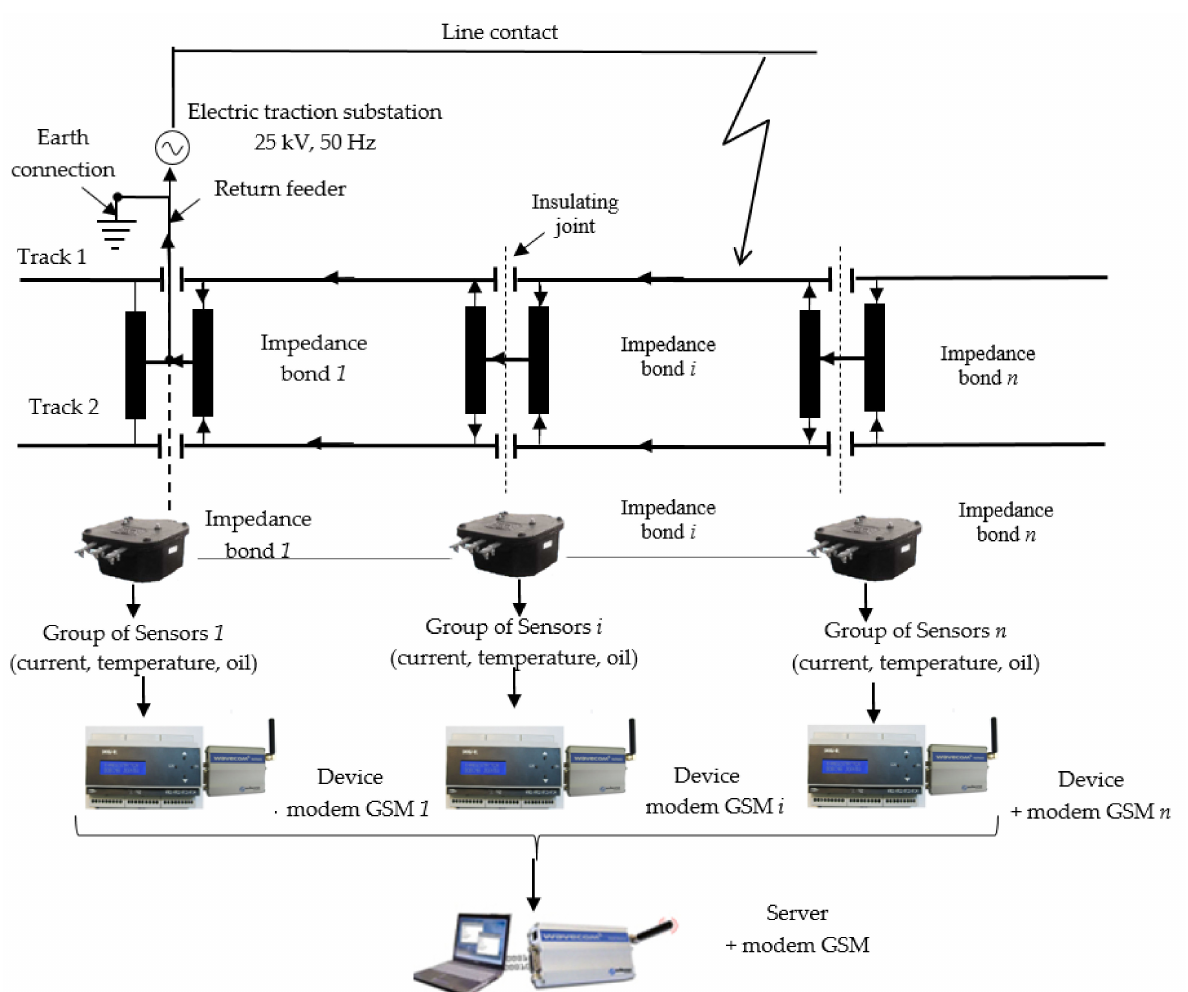
Figure 8. Architecture of an integrated monitoring and protection system of power supply system from railway infrastruc- ture using GSM